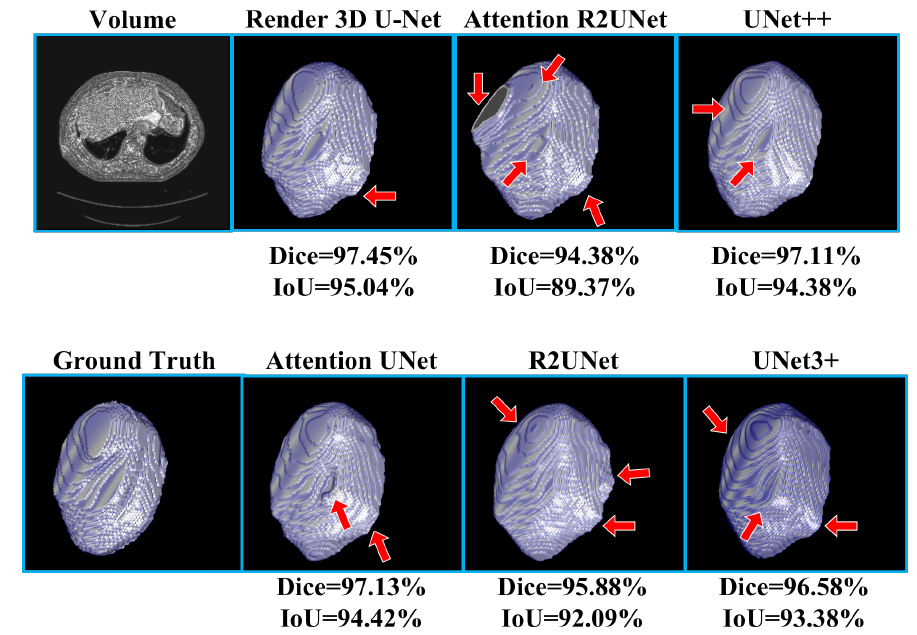
Figure 10. Comparison of model outputs and ground truth, where the prediction-missed areas are highlighted with red arrows: the prediction of Render 3D U-Net is generated under the point-sampling method and false positive classification